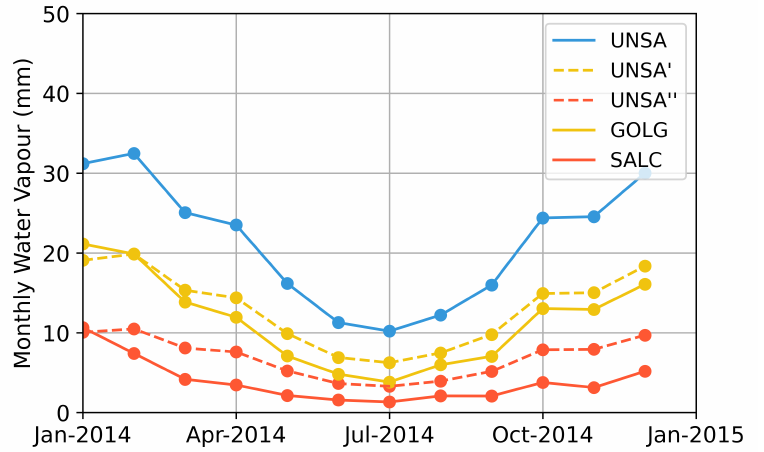
Figure 15. Projection of the mean monthly water vapour values of UNSA station (1224 m asl) at higher altitudes for the direct comparison of the readings with actual measurements at those points. UNSA’ is the water vapour content at the corresponding height of the GOLG station at 2343 m asl, and UNSA” corresponds to the SALC station at 3799 m asl. In most cases, the water vapour contents at UNSA at the corresponding heights are higher than at the measured station.